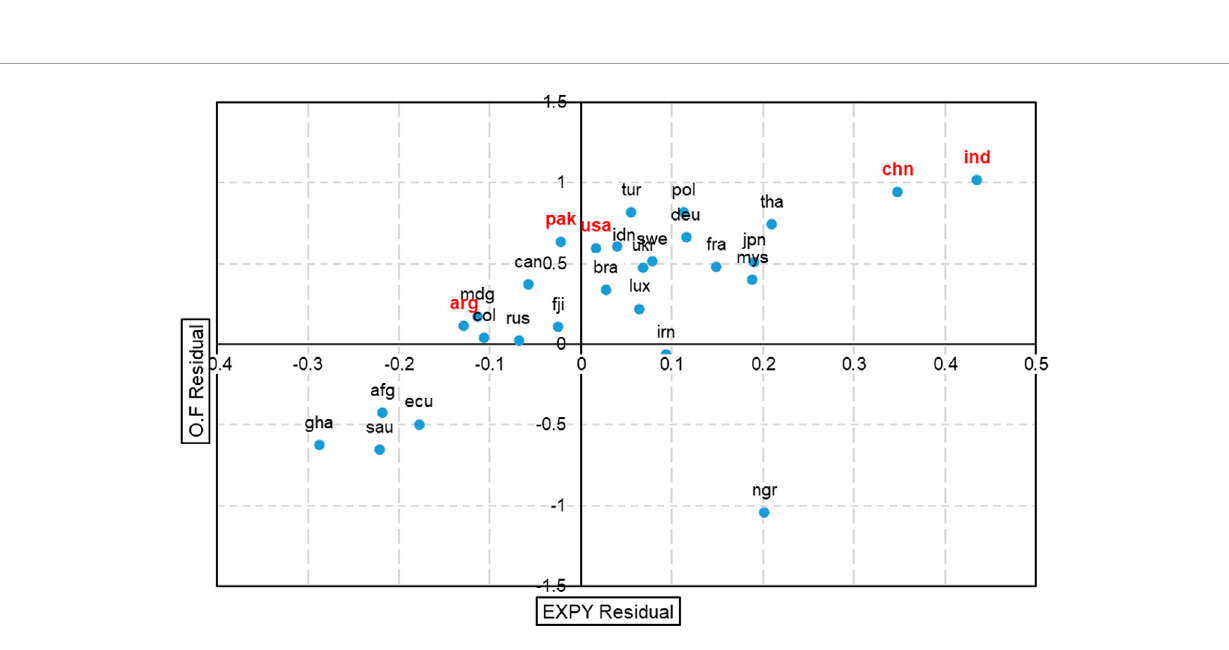
FIGURE 5 PSM, industrial policy